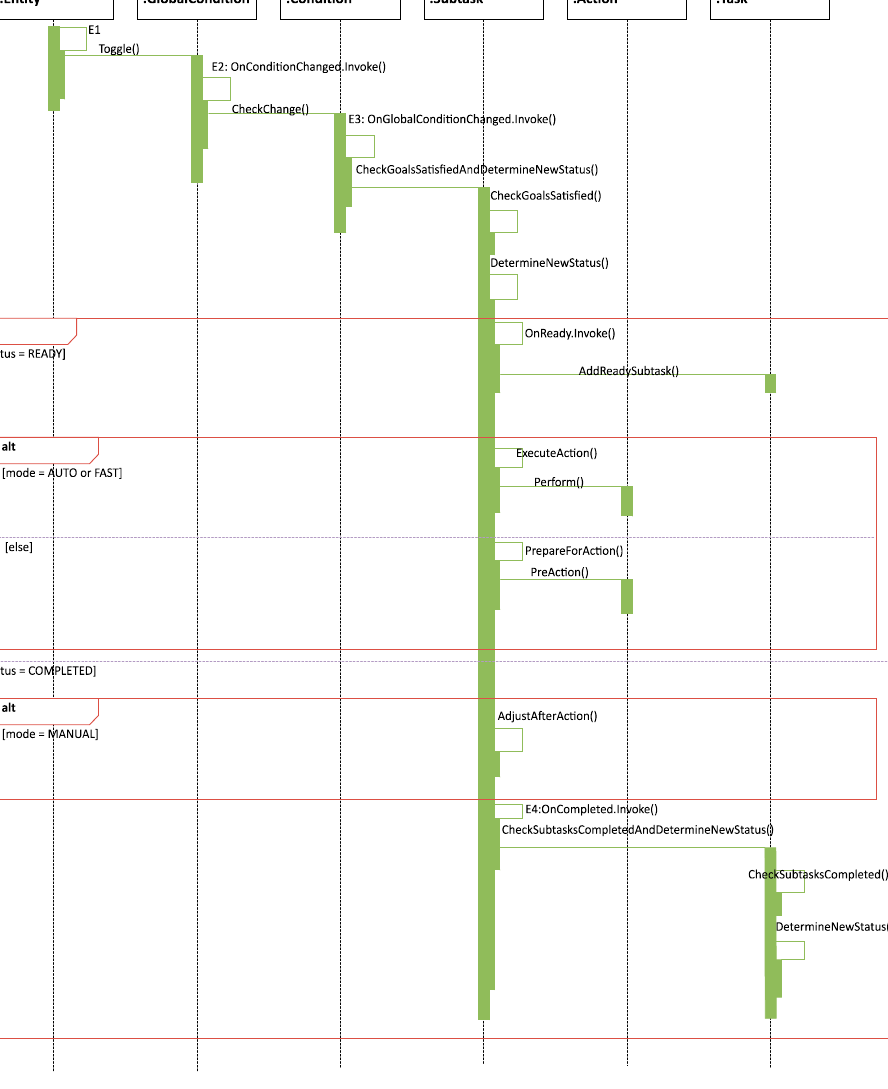
Figure 5. UML sequence diagram of the task manager.